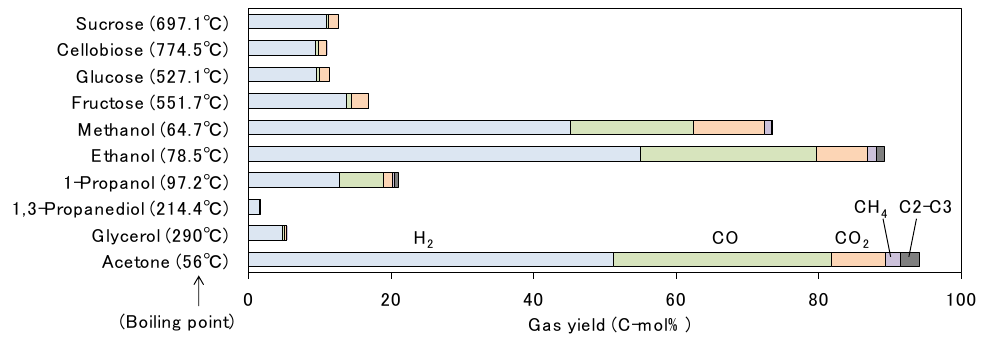
Figure 7. Comparison of the gas yields from solution-plasma treatment of various saccharides for 45 min and alcohols and acetone for 30 min (concentration, 10 g/L; electrode distance, 1.2 mm; cooled with room-temperature water; the gas yields are based on the carbon atoms in the initial